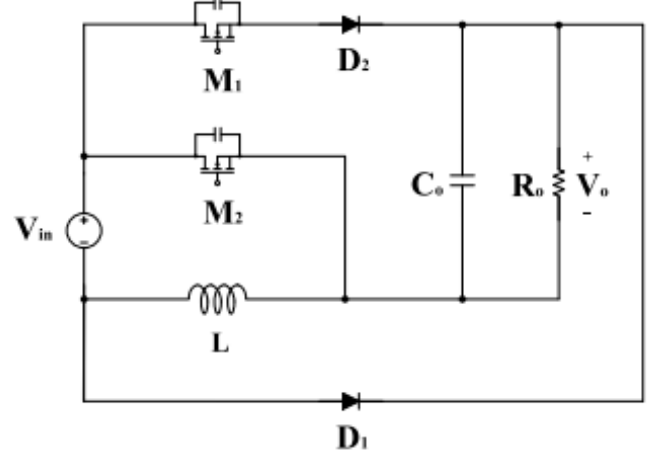
Figure 1. Two-switch buck-boost (TSBB) paradigm. Table 1. Buck-boost switch operation modes.